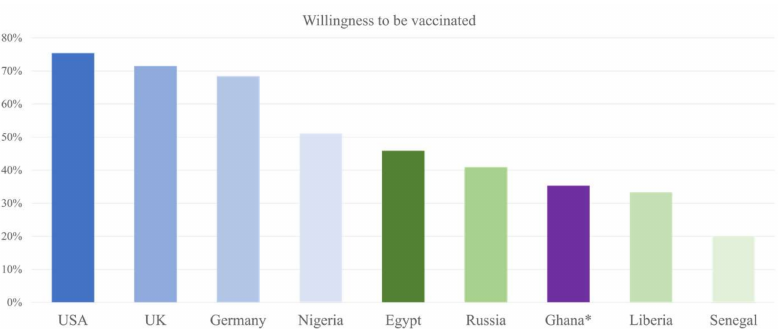
Figure 6. The readiness to receive vaccines against COVID-19 in different countries compared to Ghana. * Results reported in our